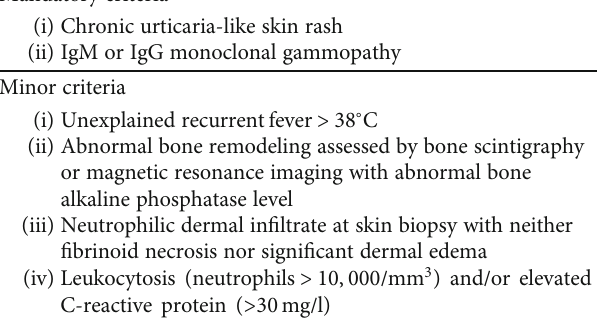
Table 4: Clinical criteria for the diagnosis of Schnitzler ’ s disease [134]. A de fi nite diagnosis is justi fi ed by the ful fi llment of the 2 mandatory criteria and at least 2 or 3 minor criteria in patients with IgM or IgG monoclonal gammopathy, respectively. Diagnosis is probable when the 2 mandatory criteria are ful fi lled and at least 1 or 2 minor criteria in patients with IgM or IgG monoclonal gammopathy, respectively, are